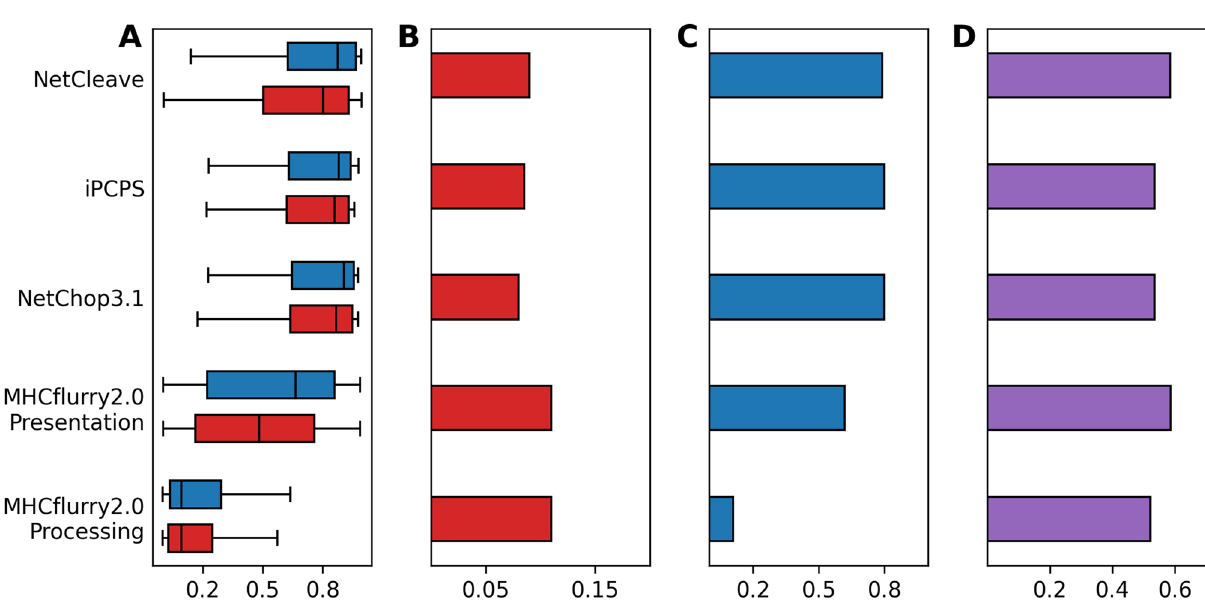
Figure 4. Immunogenicity benchmark of NetCleave, iPCPS, NetChop3.1, MHCflurry2.0 presentation and MHCflurry2.0 processing scores for H2-Kb dataset. ( A ) Prediction distribution for immunogenic (blue) and non-immunogenic peptides (red). ( B ) Precision or positive predictive value (PPV). ( C ) Recall or true positive rate (TPR). ( D ) Area under the curve (AUC)